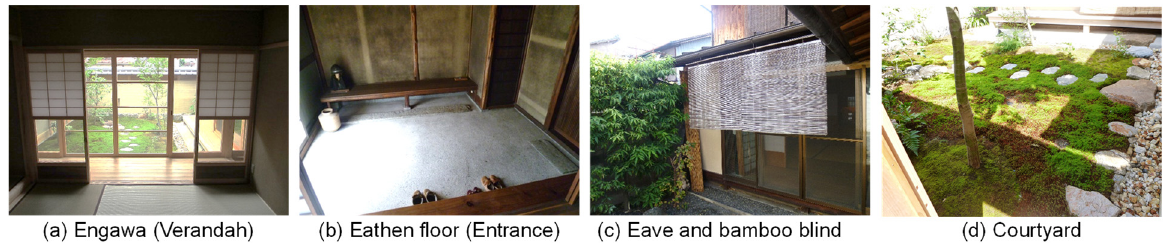
Figure 4. Examples of environment adjustment (buffer) spaces.